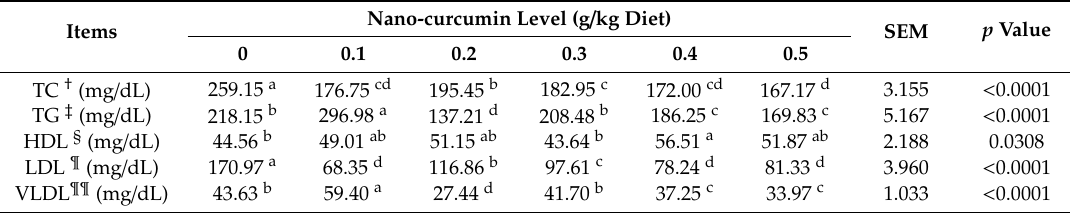
Table 6. Lipid profile of growing Japanese quail as a ff ected by dietary